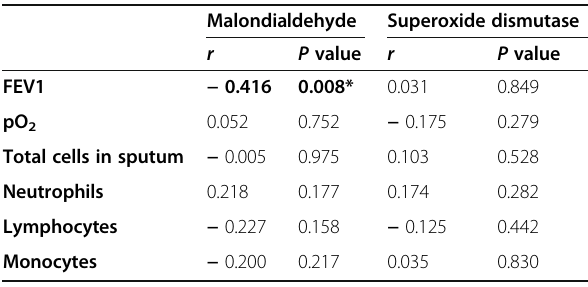
Table 6 Correlation between oxidative stress biomarkers and both pulmonary functions and sputum